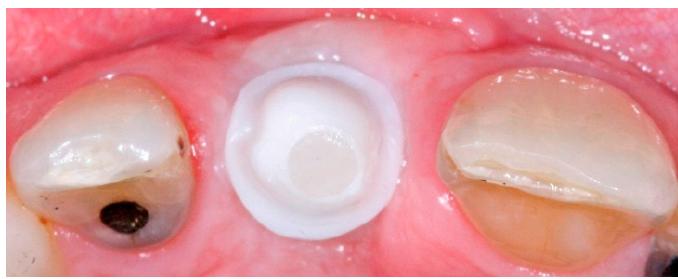
Figure 5. Zirconia custom abutment in place for anterior implant restoration with anatomic emergence profile.